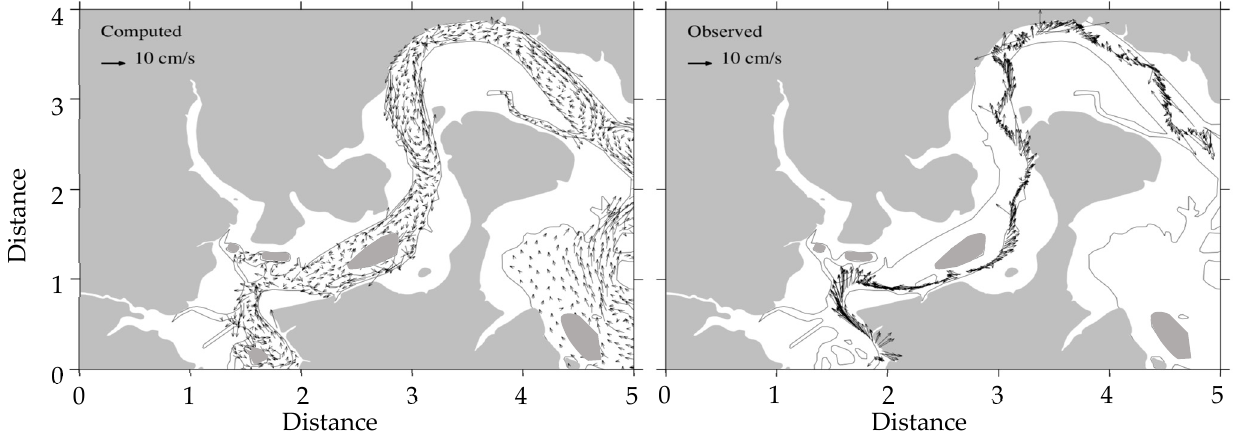
Figure 8. Comparison between model-simulated ( left ) and ADCP observed ( right ) residual currents in the Okatee River.